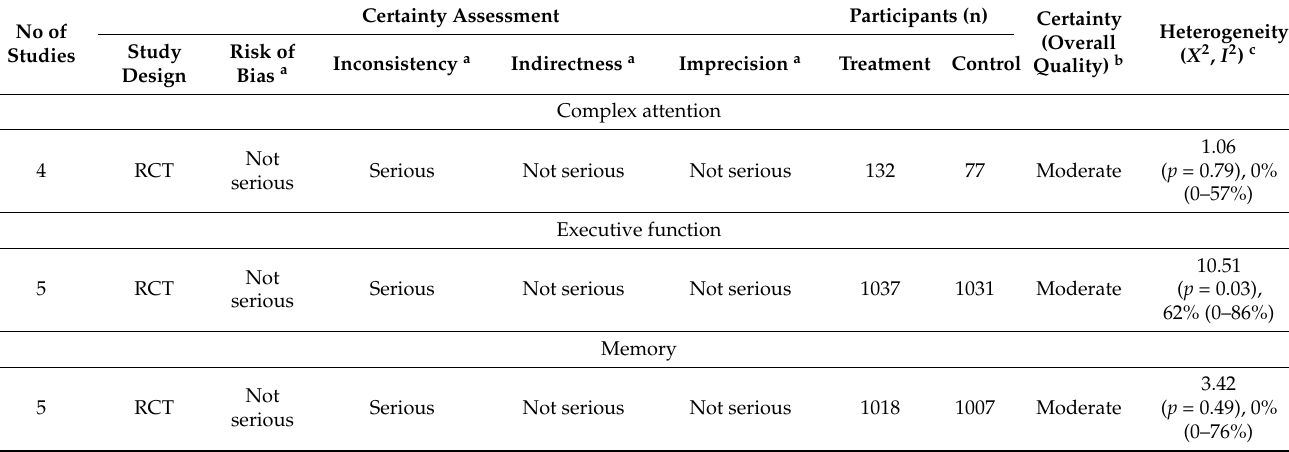
Table 2. GRADE quality of evidence assessment of complex attention, executive function and memory domains and their heterogeneity